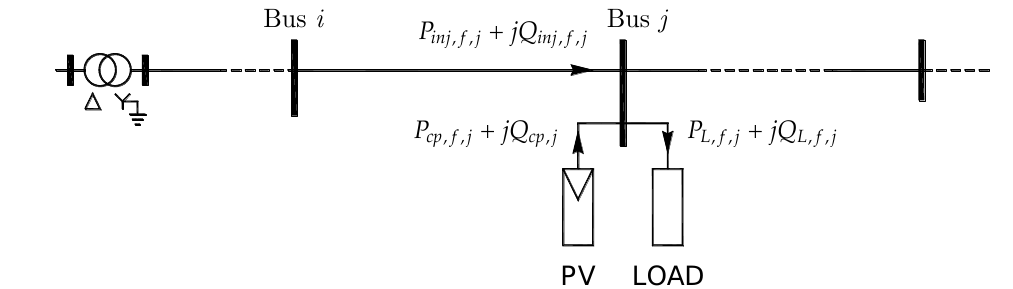
Figure 2. Direction convention for power flows at a generic bus Figure 2 . Direction convention for power flows at a generic bus j.